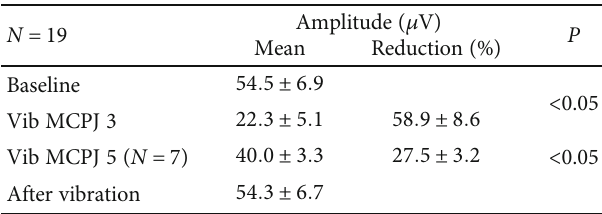
Figure 1: Schematic diagrams illustrating the settings of the experiment with conditioning stimulation of vibration. Table 1: Measurements of digit 3